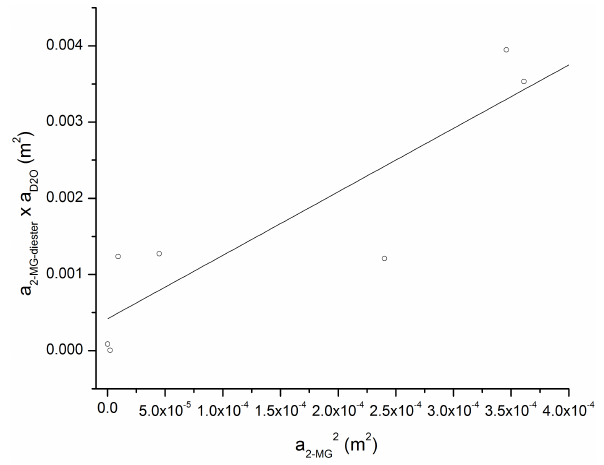
Fig. 6. Equilibrium constant ( K eq ) determination from perchloric acid